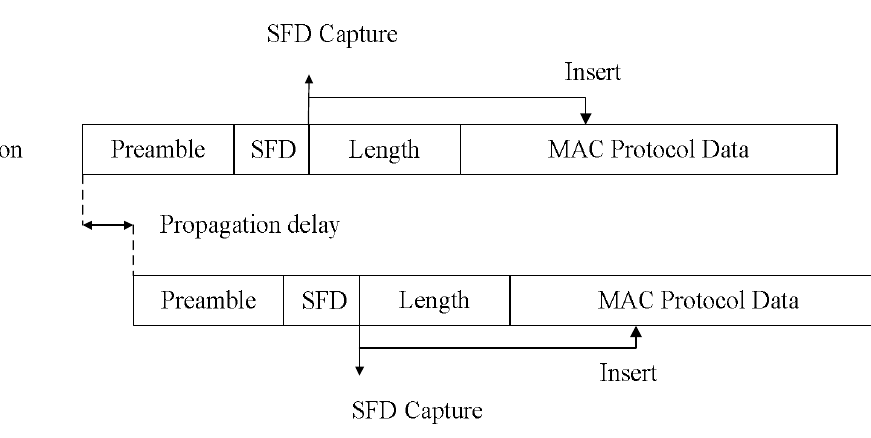
Figure 5. Time stamping point during synchronization